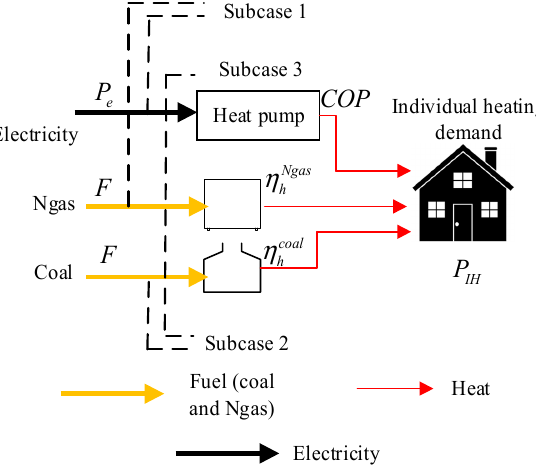
Figure 10. Coal, Ngas and heat pump are used to meet individual heating demand.